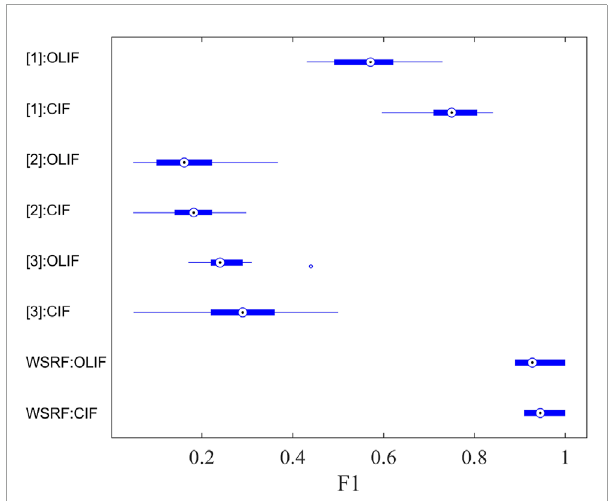
FIGURE 11 F1 of different methods. CIF: Cable incipient fault. OLIF: Overhead line incipient fault. [1]: The method from Song and Chang. (2009) [2]: The method from Simonyan and Zisserman. (2015). [3]: The method from Li.